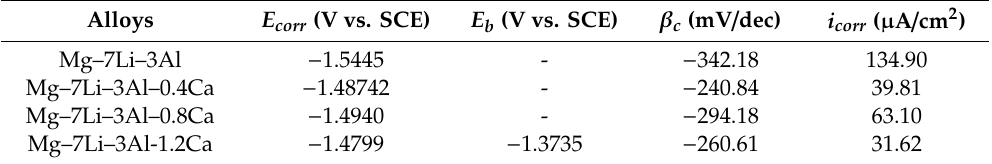
Figure 7. Potentiodynamic polarization curves of the extruded Mg–7Li–3Al–xCa alloys. The measurements were performed in a 3.5 wt.% NaCl solution.